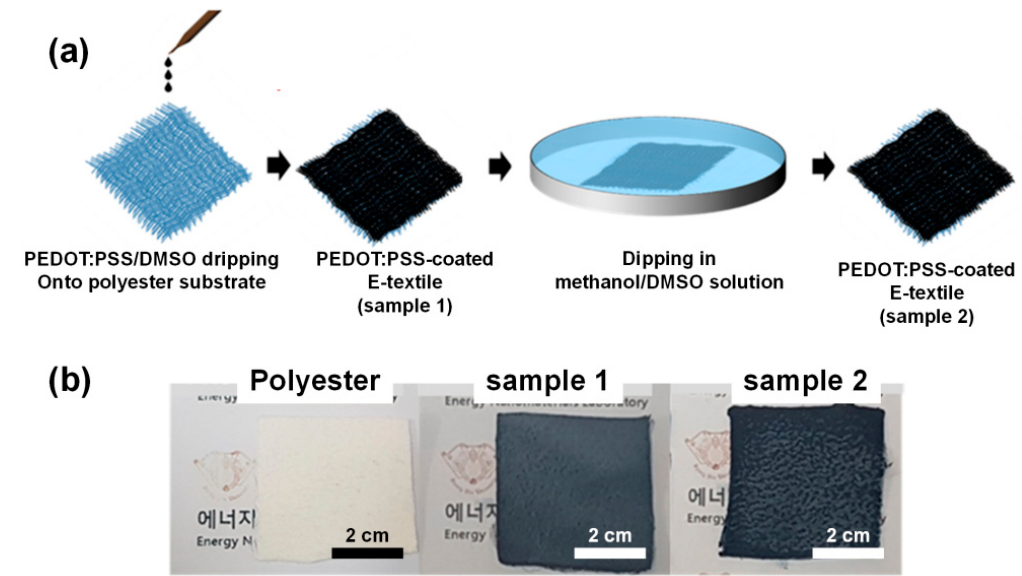
Figure 1. ( a ) Schematic illustration of the preparation of electronic textiles (E-textiles) and ( b ) the photographs of the E-textiles with a polyester textile substrate.